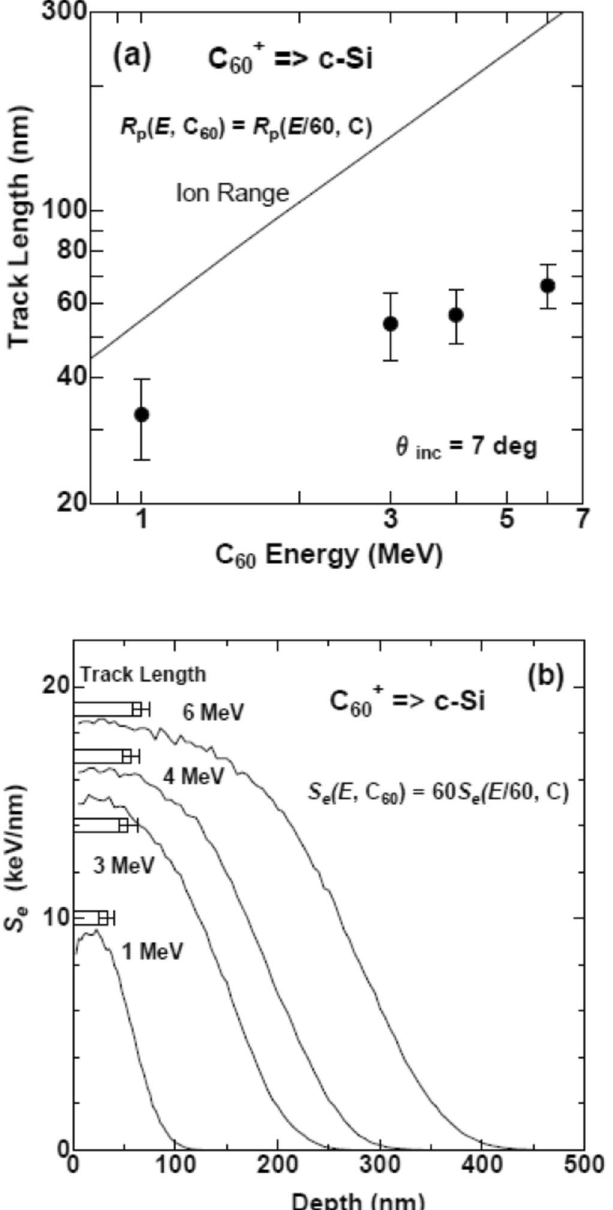
and 6 MeV, calculated by Eq. (1) using SRIM 2013 15 (www.srim.org). The track lengths observed by XTEM are shown by rectangles with error